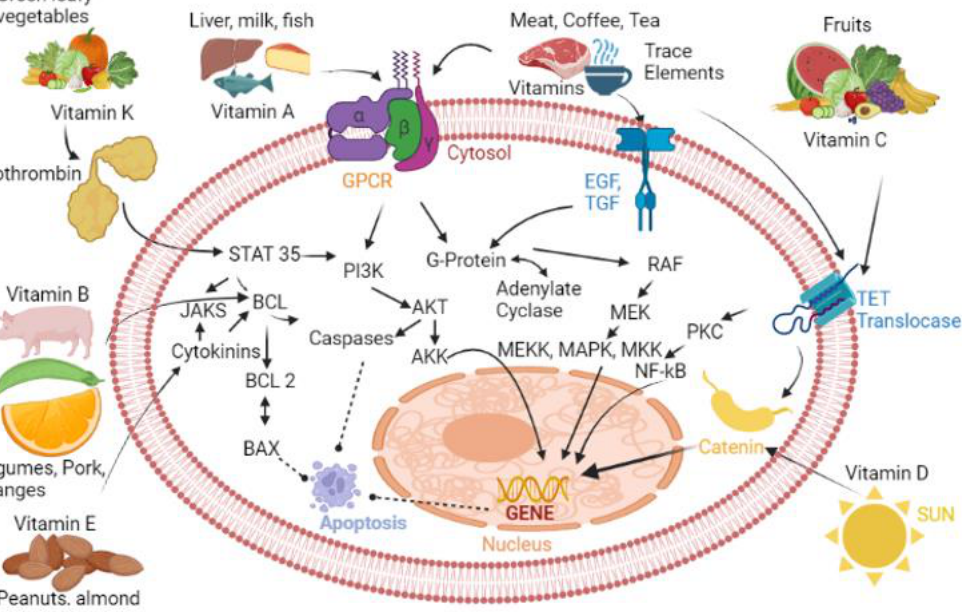
Figure 1. Cancer-associated cell signaling pathways that can be regulated by selected vitamins and minerals. List of abbreviations: GPCR, G-protein-coupled receptor; EGF, Epidermal growth factor; TGF, Transforming growth factor; NF- κB , Nuclear Factor kappa B; AKT, Serine/threonine kinase; MAPK, Mitogen-activated protein kinase; MEKK, MAPK/EKK kinase kinase; MKK, MAPK Kinase; PKC, Protein Kinase C; PI3K, Phosphatidylinositol-3-kinase; BCL, B-cell lymphoma protein; AKK, Serine/threonine kinase 2; JAKS, Janus kinase.